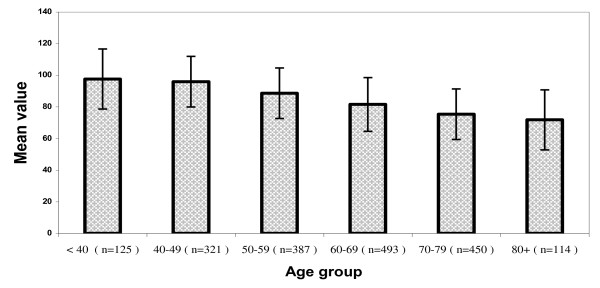
Stiffness Index (SI) values in study's population. This figure depicts a categorization of stiffness index values and number of participants in our study population according to age-decade only. No significant decline in stiffness index was seen in women (premenopausal and postmenopausal) below 50 years. This parameter exhibits a fall pattern especially after the 6th decade as seen in the figure (p = 0.001).